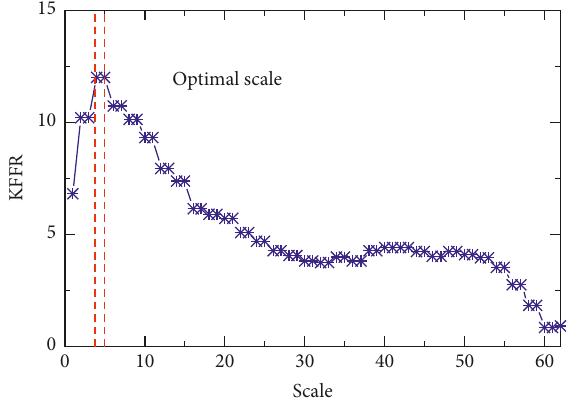
Figure 6: KFFR values of filtering results with different scales.